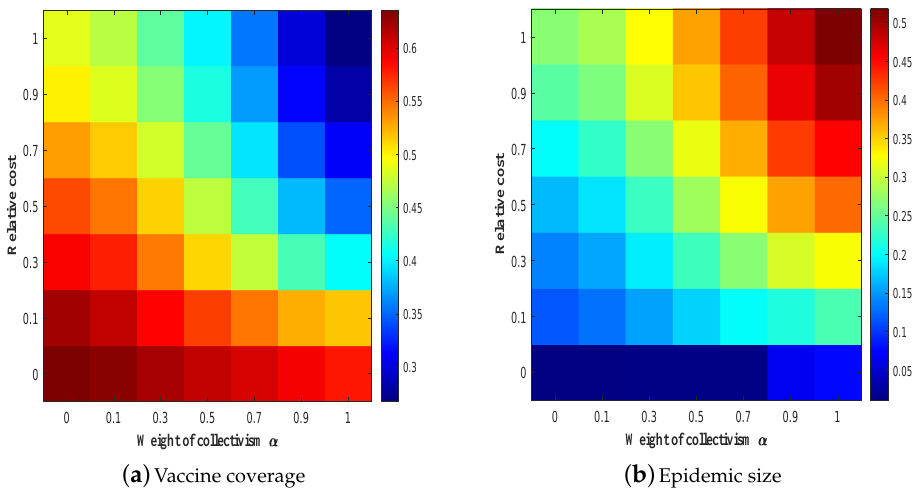
Figure 9. The relationship between vaccine coverage and epidemic size with relative cost c and the weight α . ( a ) The change of vaccine coverage. ( b ) The change of epidemic size. When c is fixed, vaccine coverage is inversely proportional to α while the epidemic size is proportional to α